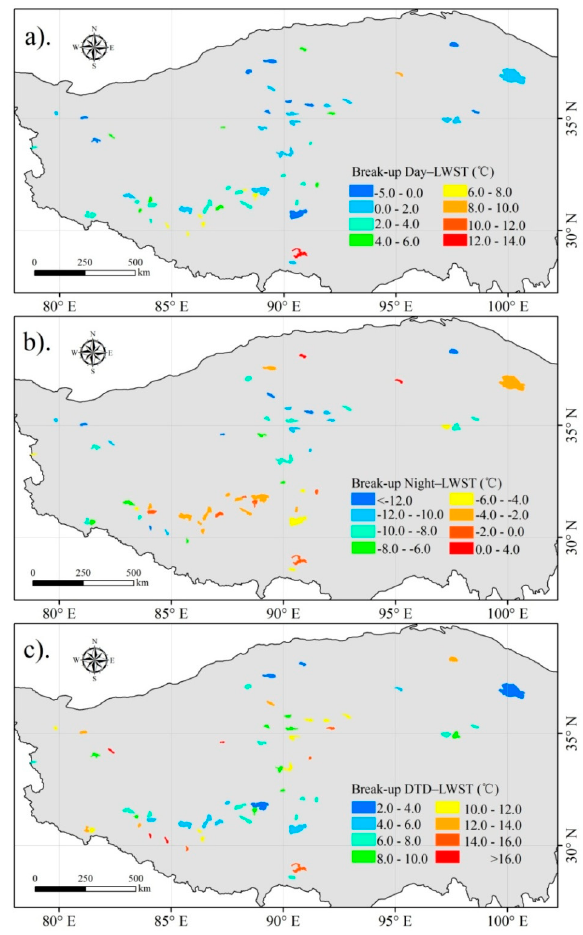
Figure 3. Spatial pattern of the monthly averaged water surface temperature after ice break-up month: ( a ) daytime lake water surface temperature (LWST) variation; ( b ) nighttime LWST variation; and ( c ) lake water surface diurnal temperature difference (DTD).